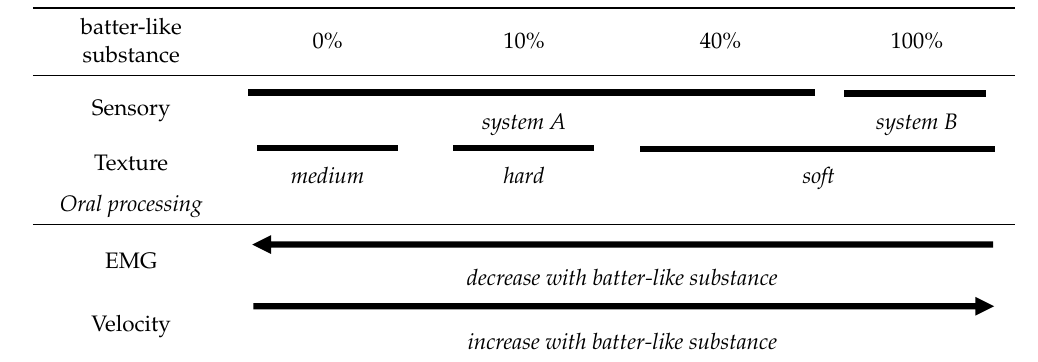
Table 4. Significant differences between the samples with increasing amount of BLS visualized for each of the three applied measurement methods.